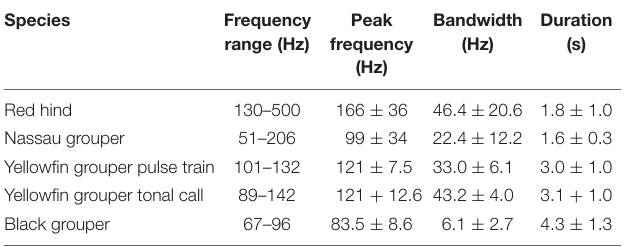
TABLE 1 | Grouper sound characteristics from the published literature.